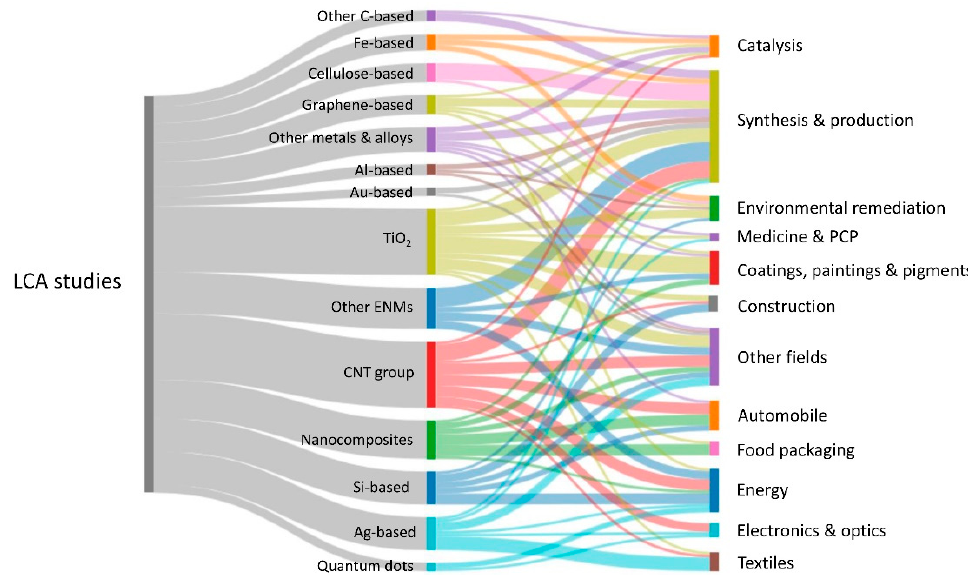
Figure 9. LCA application in different nanotechnology fields, including the nanomaterials studied. ENMs: engineered nanomaterials; PCP: personal care products; other metals and alloys: some of the most studied were Zn ‐ based and Cu ‐ based; other ENMs: some of the most studied were tungsten ‐ based and zirconia ‐ based.